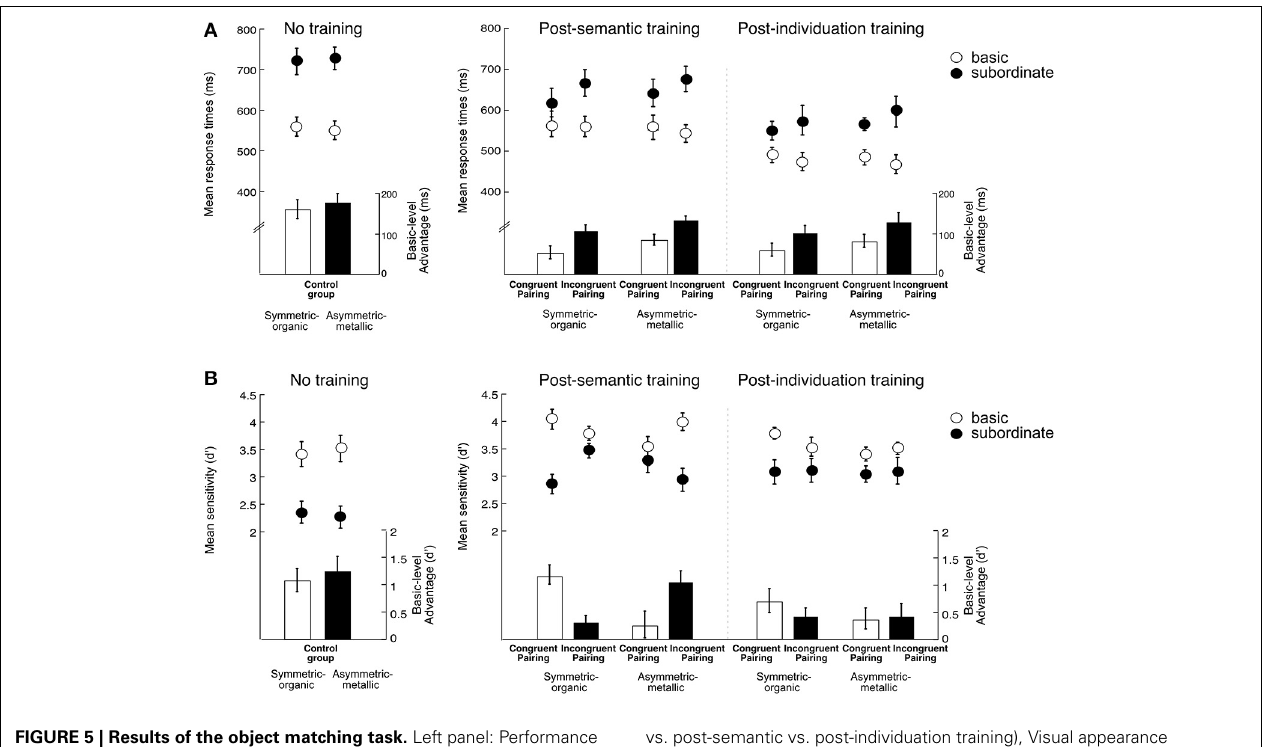
vs. post-semantic vs. post-individuation training), Visual appearance (Symmetric-organic Greebles vs. Asymmetric-metallic Greebles) and Categorization level (Basic vs. Subordinate). The dots represent mean response times or mean sensitivity, and the bars represent the mean basic-level advantage. Error bars represent the standard errors of the